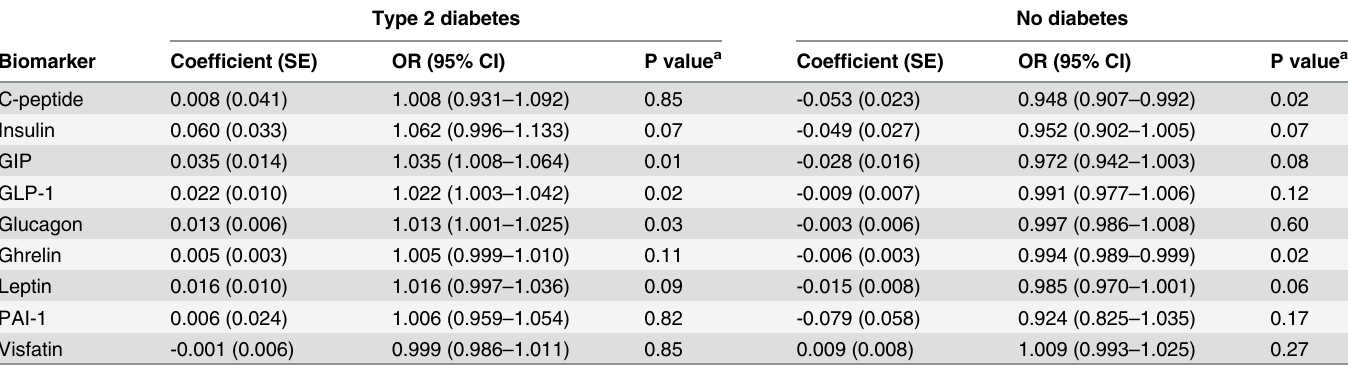
Table 3. Logistic regression analysis with periodontal status as dependent variable (yes/no). Type 2 diabetes No